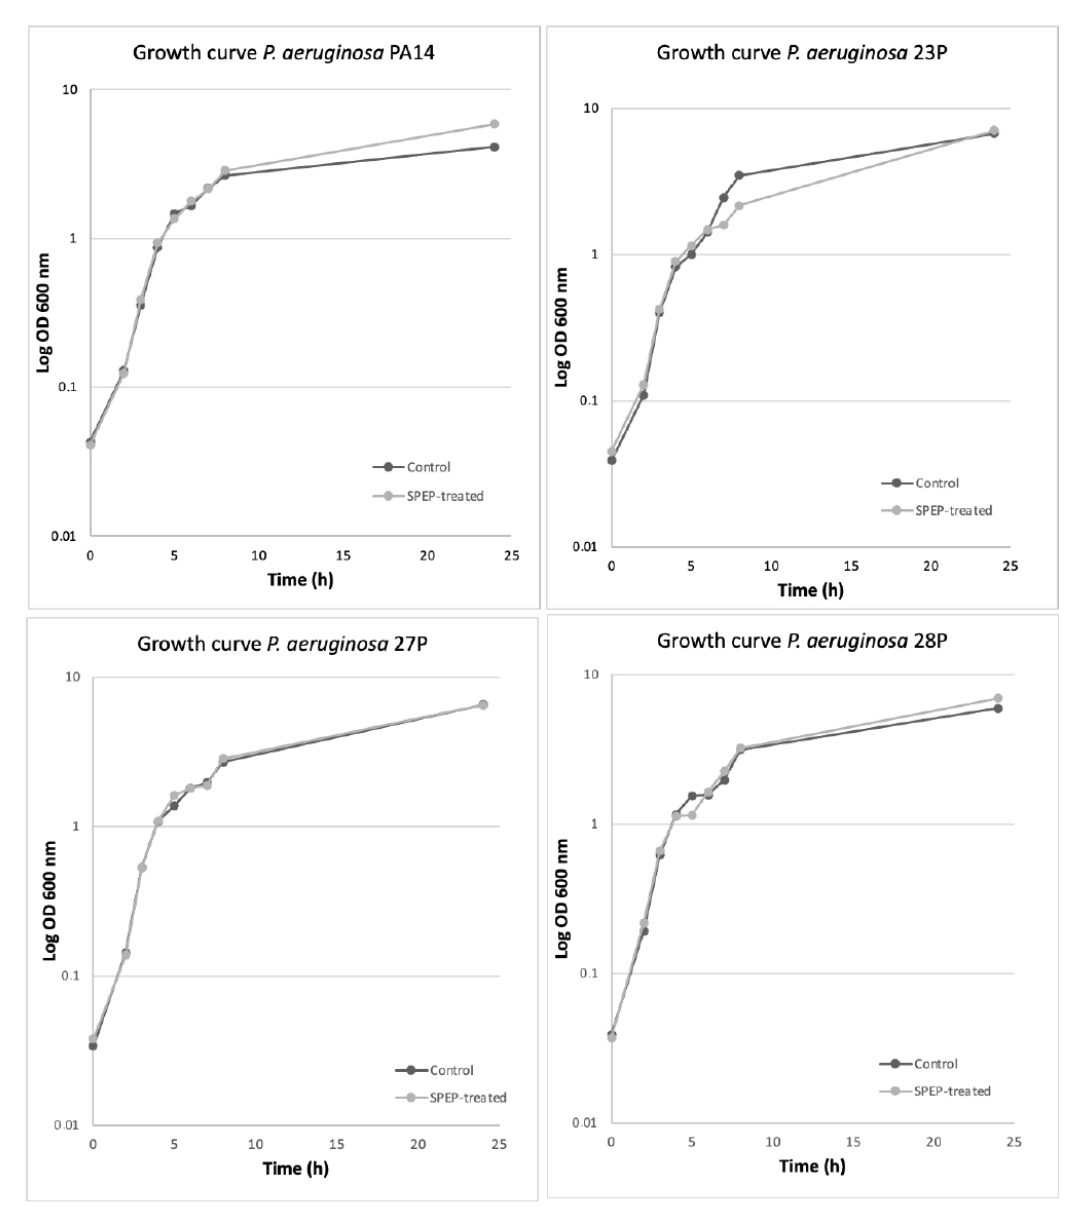
Adhesion is expressed as CFU of bacteria that adhered to A549 cells 1 h post-infection at 37 ◦ C. Invasion efficiency is expressed as CFU of bacteria that were gentamicin-resistant 1 h post-infection. Data represent the mean ± SD of three independent experiments.